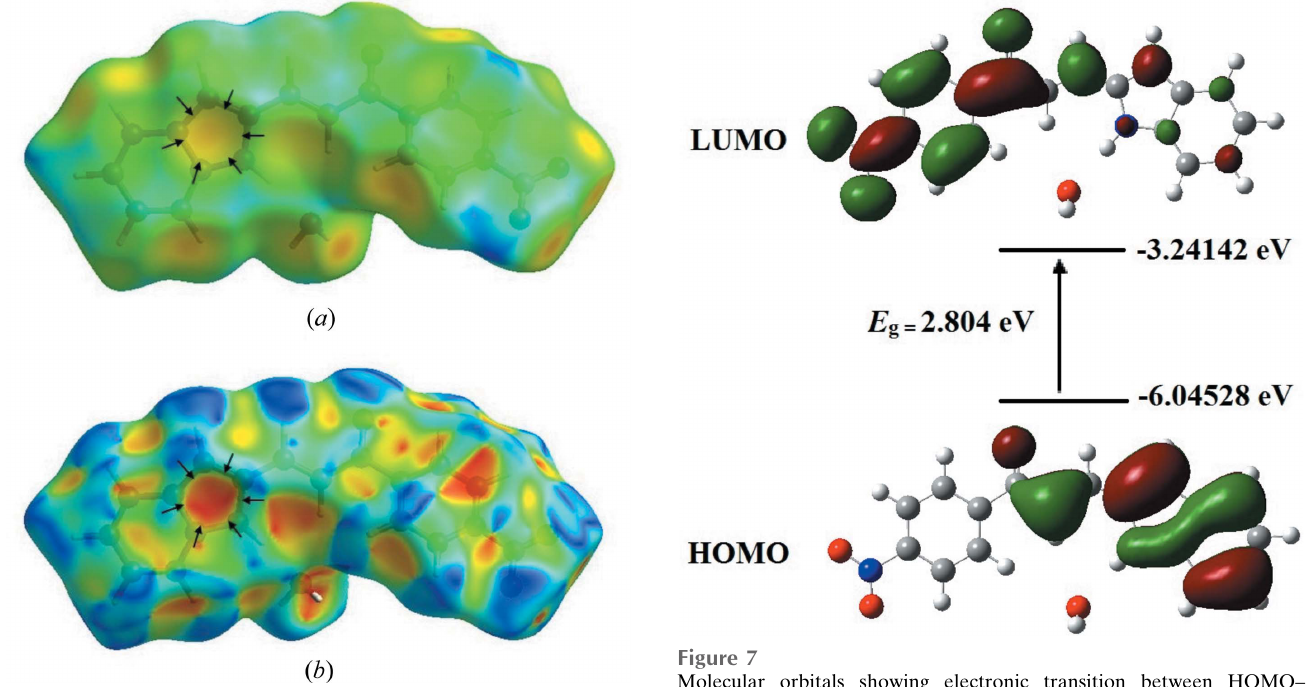
Figure 6 Graphical view of the Hirshfeld surfaces for the title compound ( a ) mapped over d e with a pale-orange spot and ( b ) mapped over shape- index with a bright-red spot, both inside the black arrows, signifying the involvement of the C—H (cid:2)(cid:2)(cid:2) (cid:2) indexed mapping, the C—H (cid:2) (cid:2) (cid:2) (cid:2) interactions can be observed as a bright-red spot identified with black arrows in Fig. 6 b . The blue spots near the ring represent the reciprocal C—H (cid:2) (cid:2) (cid:2) (cid:2)